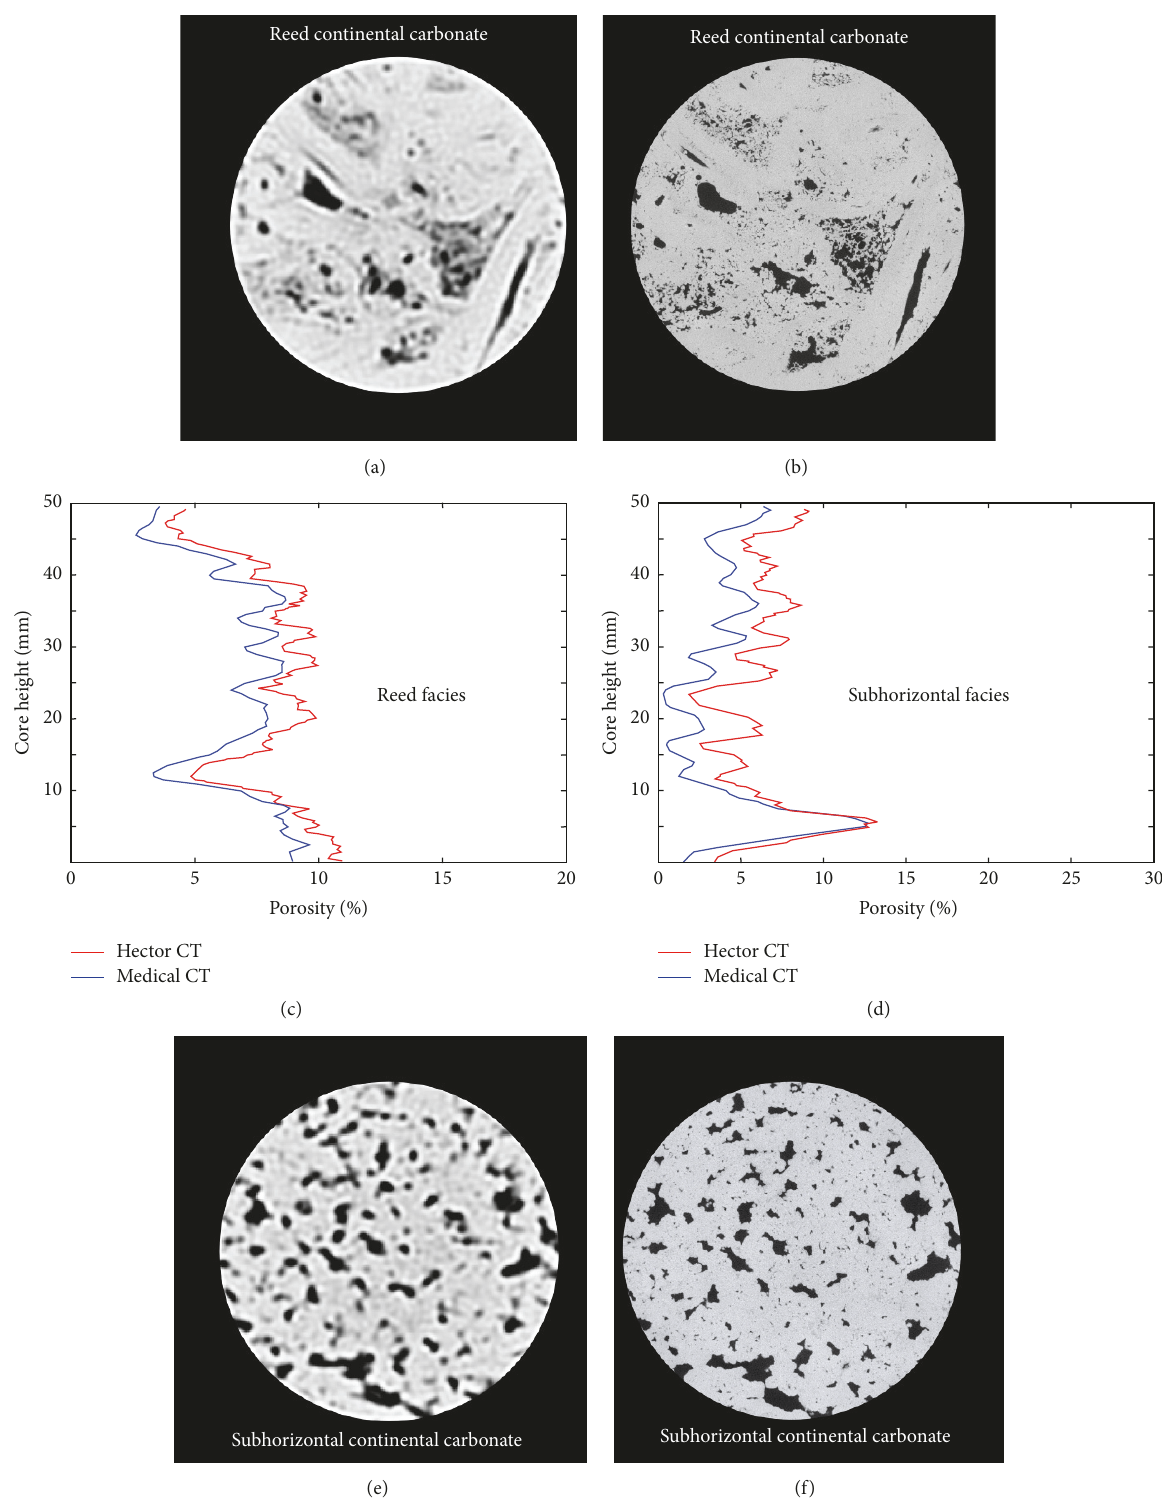
Figure 9: Influence of the resolution on the measured porosity network in whole cores with a diameter of 9.7 cm. ((a) and (b)) Medical CT and HECTOR slice of a reed continental carbonate with 230 𝜇 m and 28 𝜇 m resolution, respectively. (c) Comparison of the calculated porosity in function of the core height for a reed continental carbonate. (d) Comparison of the calculated porosity in function of the core height for a subhorizontal continental carbonate. ((e) and (f)) Medical CT and HECTOR slice of a subhorizontal continental carbonate, with 230 𝜇 m and 28 𝜇 m resolution,